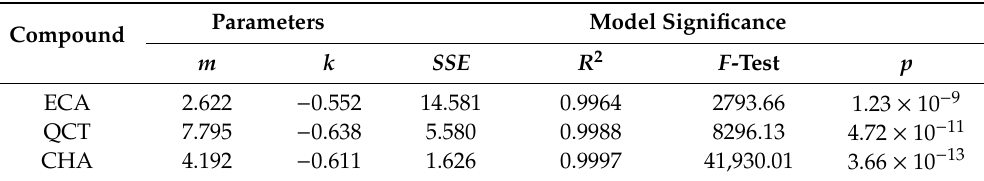
Table 3. Estimated model parameters for the dose-response curves of the main extracts’ constituents in the O 2 •− scavenging capacity assay according to Equation (2). Parameters Compound